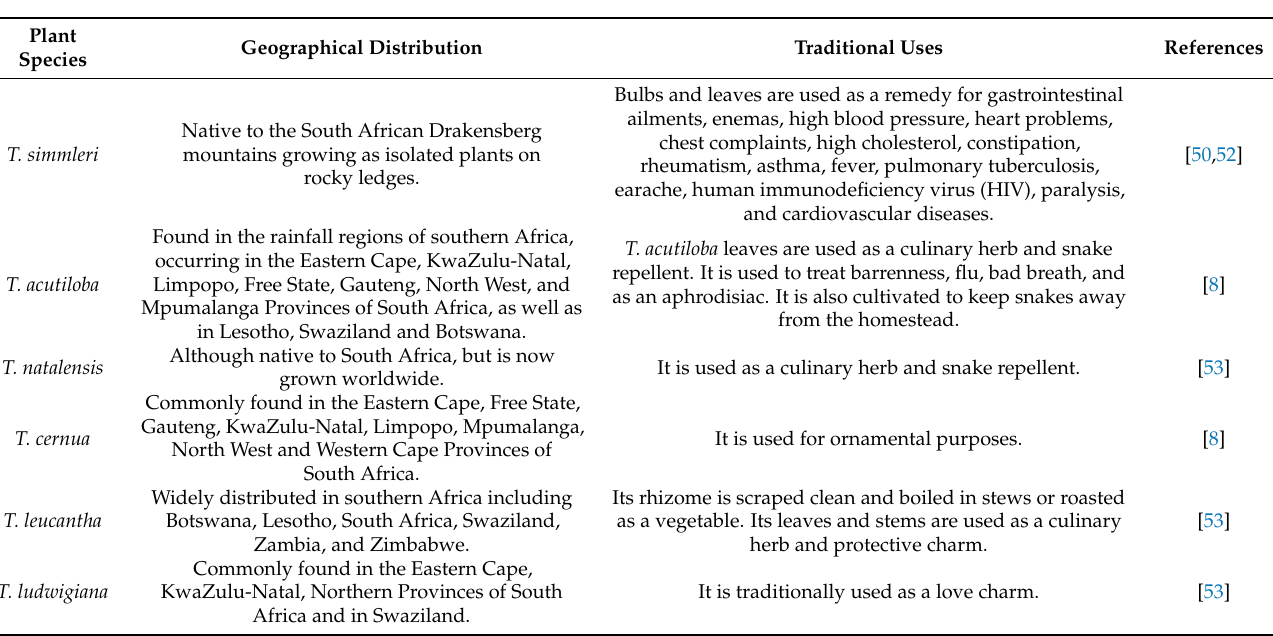
Figure 2. Analysis of cLogP and molecular weight space occupied by compounds identified in T. violacea . Blue circles are sulfur-containing compounds while red circles are compounds devoid of sulfur in their chemical structures. Plot generated using DataWarrior [54]. Tulbaghia violacea has been the most widely investigated for its phytochemistry and pharmacological properties. To date, close to 100 compounds have been tentatively iden- tified, largely using gas chromatography techniques, from different parts of this species (Supplementary File S1) [55]. Most prominent are the sulfur compounds with reported broad-spectrum pharmacological activity. The thiosulfinate marasmicin ( 1 ) is the most prolific antimicrobial compound reported thus far from this genus [56]. This compound is formed from its precursor compound marasmin ( 2 ), by the enzyme c-lyase. Marasmicin